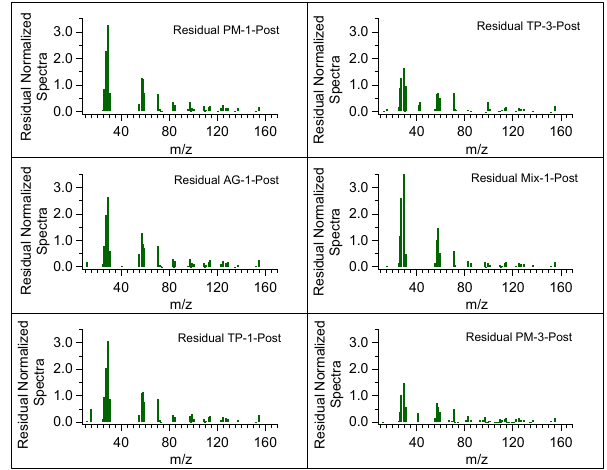
Figure 6. Residual stress spectra calculated by subtracting the opti- mized linear addition of the paired baseline + MeJA standard spec- tra from the post-treatment stress spectra. The x axis is the m/z value and the y axis is the residual. Negative residuals have been removed to focus on the enhanced m/z